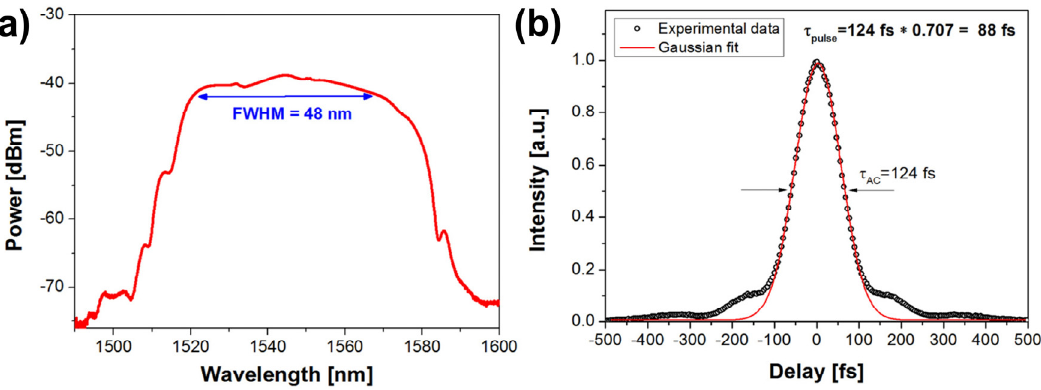
Figure 5. ( a ) The optical spectrum with FWHM of 48 nm. ( b ) The autocorrelation trace. Both measured at 110 mW pump power level. Reproduced from ref. [58]. Optical Society of America, 2015.